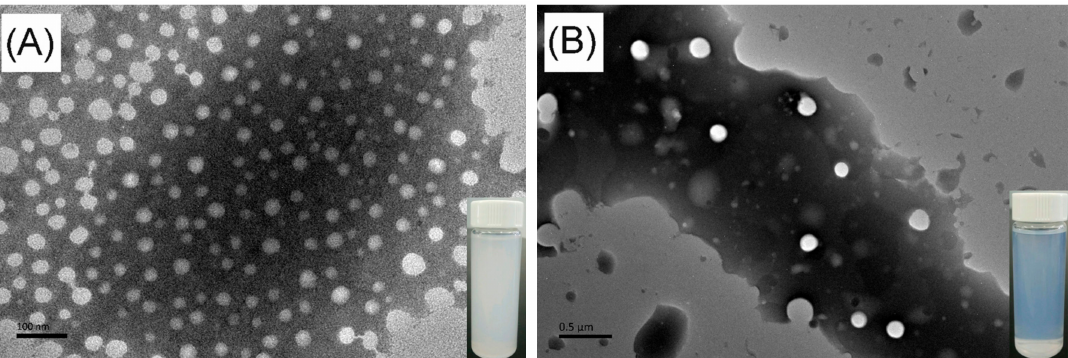
Figure 7. TEM images of hPTE-1 ( A ) and lPTE-1 ( B ) nanoparticles.